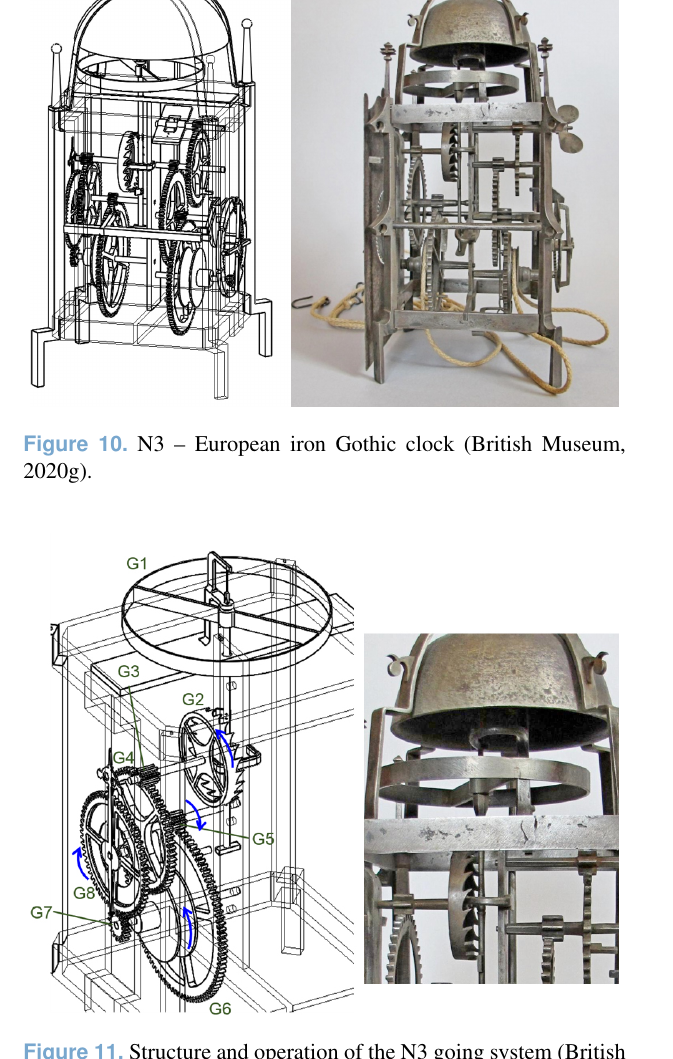
Figure 11. Structure and operation of the N3 going system (British Museum, 2020g).